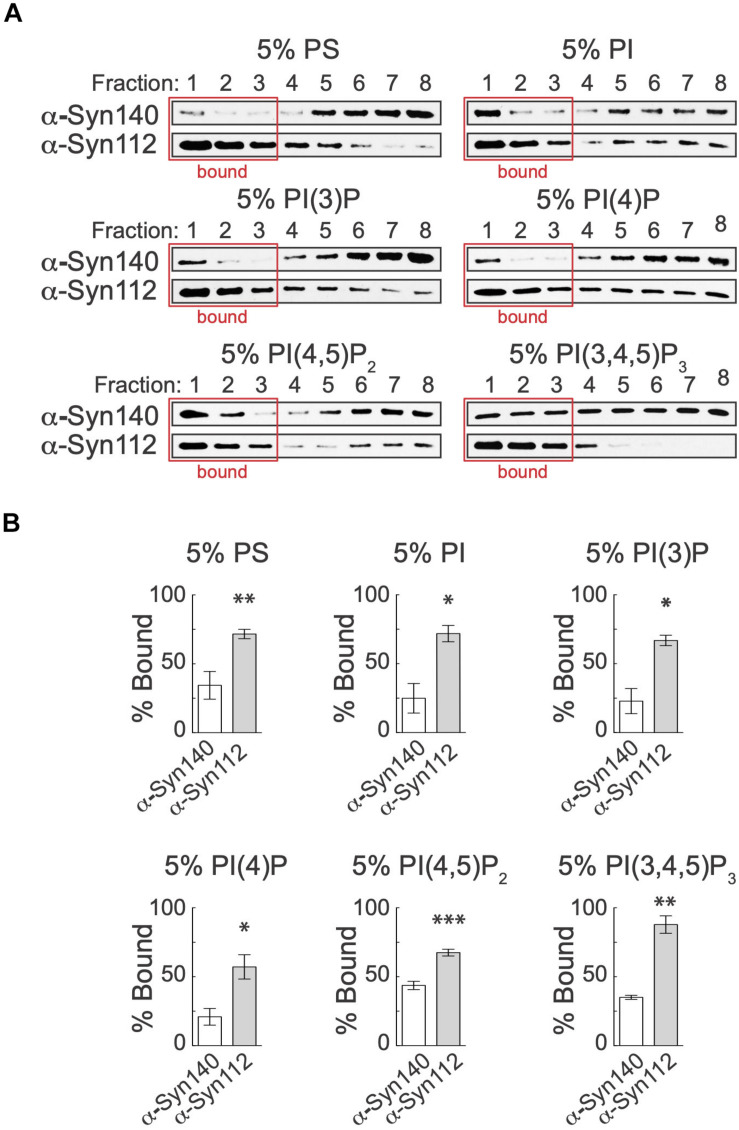
α-Syn-112 exhibits enhanced binding to anionic phospholipids. (A) Representative Western blots showing α-syn-140 and α-syn-112 binding to liposomes containing 5% PS, PI, PI(3)P, PI(4)P, PI(4,5)P2, and PI(3,4,5)P3. Red box indicates liposome-containing fractions. α-Syn-112 bound with increased efficacy to all liposomes containing anionic phospholipids. (B) Quantification of lipid bound protein show enhanced binding to all anionic phospholipids tested. (PS = α-syn-140: 34.42 ± 10.07, n = 5; α-syn-112: 71.50 ± 2.76, n = 5; p = 0.0038) (PI = α-syn-140: 24.90 ± 10.73, n = 3; α-syn-112: 71.78 ± 5.91, n = 3; p = 0.0187) (PI(3)P = α-syn-140: 22.83 ± 9.1, n = 3; α-syn-112: 66.86 ± 3.78, n = 4; p = 0.0014) (PI(4)P = α-syn-140: 20.91 ± 6.05, n = 3; α-syn-112: 57.07 ± 8.83, n = 4; p = 0.0264) (PI(4,5)P2 = α-syn-140: 43.68 ± 3.00, n = 4; α-syn-112: 67.50 ± 2.48, n = 4; p = 0.0009) (PI(3,4,5)P3 = α-syn-140: 35.02 ± 1.457, n = 3; α-syn-112: 87.84 ± 6.33, n = 3; p = 0.0012). Data points indicate mean ± SEM. Asterisks indicate statistical significance by Student’s t-test. *p < 0.05, **p < 0.01, ***p < 0.001.